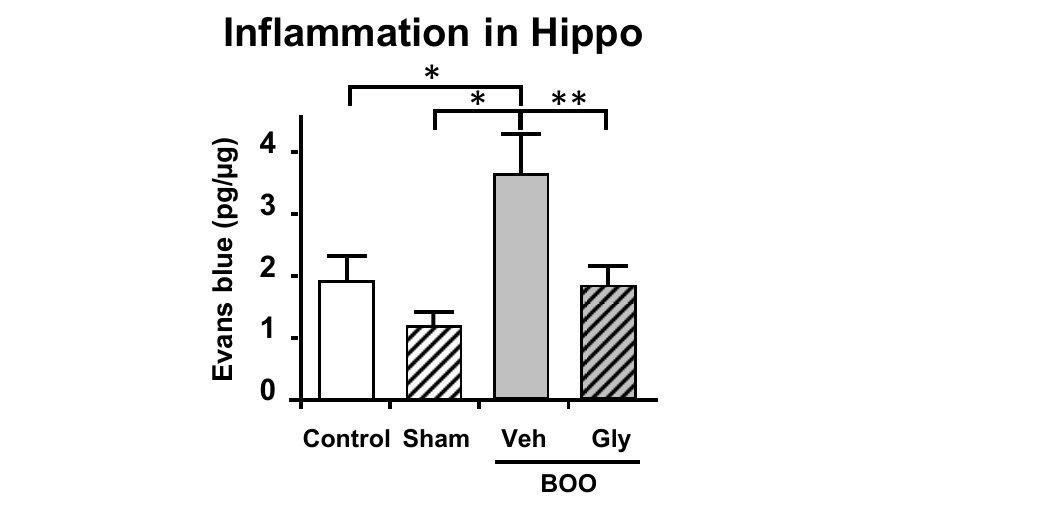
Figure 6. After 12 weeks of BOO, inflammation is present in the hippocampus of rats. This inflammation is blocked by concomitant treatment with glyburide. Following the treatments indicated, inflammation was assessed by the Evans blue assay as described in the Materials and Methods section. Veh = vehicle- treated, Gly = glyburide-treated. Results are the mean ± 95% confidence intervals; * p < 0.05 and ** p < 0.01 by ANOVA and Dunn’s test. ( n = 8, 7, 12, 8). This figured was reprinted, with permission from the Wiley Periodicals, from [9].